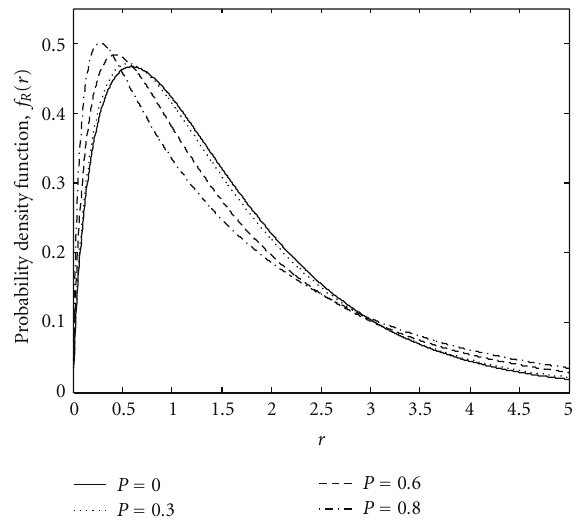
Figure 2: Probability density function of correlated cascade Rayleigh